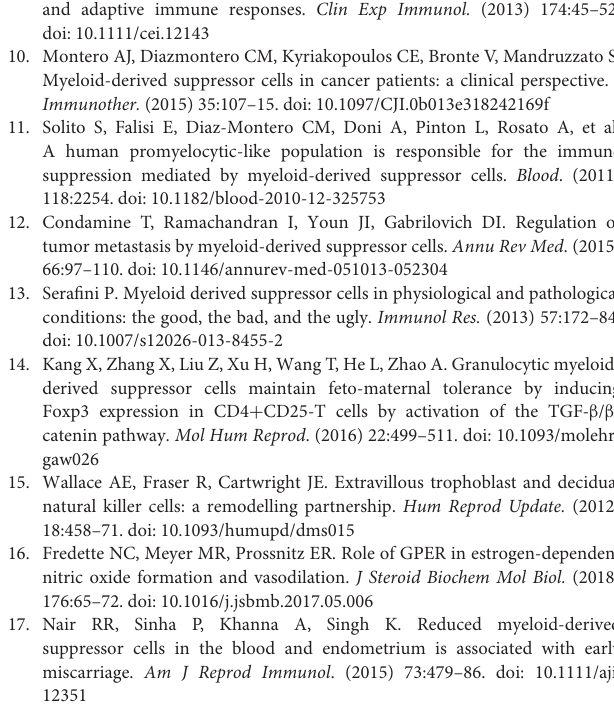
Supplemental Figure 2 | MDSC suppress T cell responses in IVF patients. (A) Proliferation of CD3 + CD4 + T cells and CD3 + CD8 + T cells in PBMC or PBMC without MDSC from peripheral blood of IVF patients. (B) Analysis of CD3 + CD4 + T cells and CD3 + CD8 + T cells proliferation in control, PBMC and PBMC without MDSC with different serum E 2 level. (C) Statistical analysis of groups when serum E2 level less than 4,000 pg/ml. (D) Statistical analysis of groups when serum E2 level more than 4,000 pg/ml. Supplemental Figure 3 | 17 β -estradiol induced MDSC augment and elevated VEGF level in vitro . Flow cytometry analysis showed that percentage of MDSC